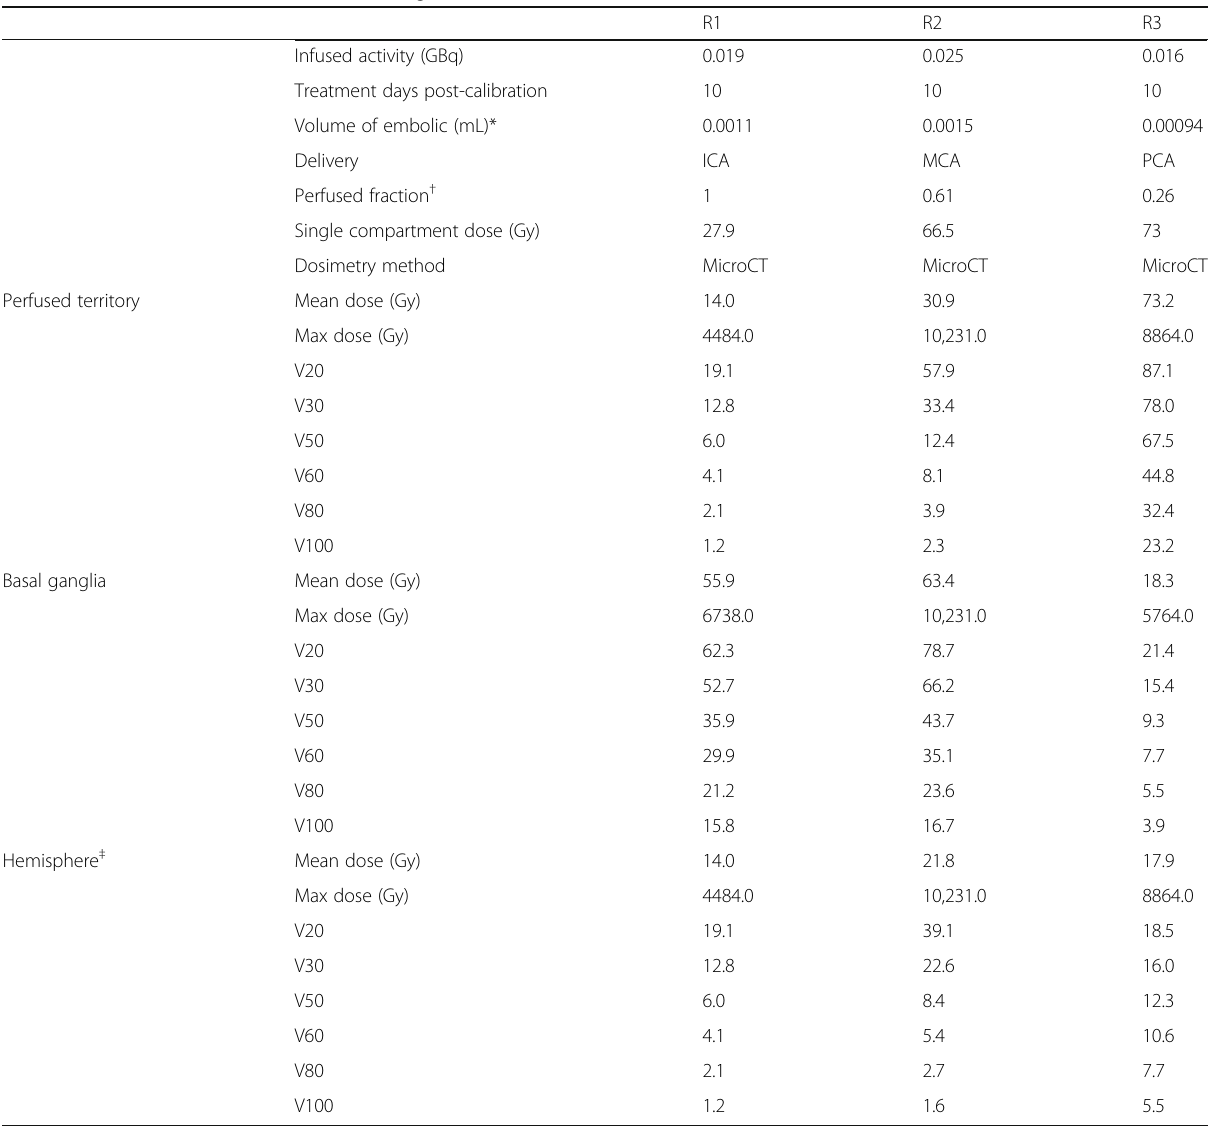
Table 1 Treatment dose data for research dogs